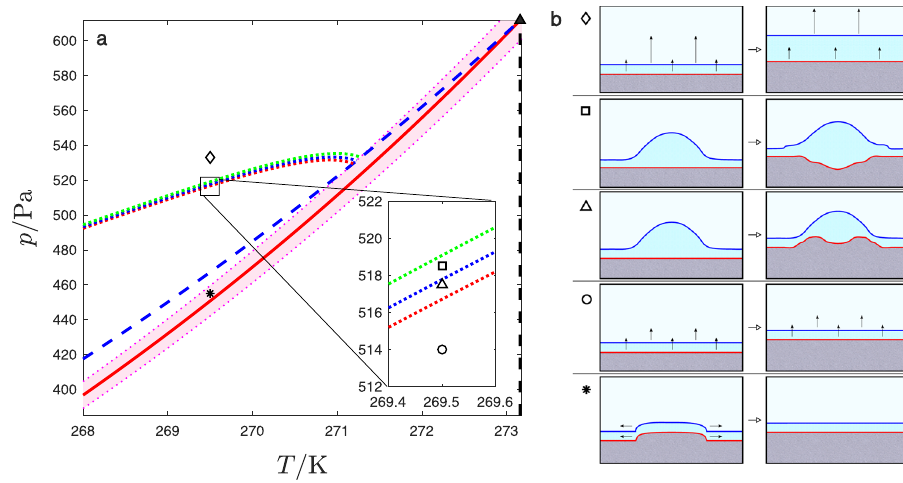
Fig. 3 Kinetic phase diagram for ice crystal growth. Panel a shows the equilibrium phase diagram and kinetic phase lines. The red solid line is the sublimation line, whereas the dashed lines are metastable prolongations of the vaporization (blue) and melting (black) lines. The fi lled triangle ( ▴ ) indicates the triple point where these lines meet. The remaining features describe the outcome of the dynamics. The shaded area designates the region of activated growth. The dotted lines are kinetic phase lines corresponding to kinetic coexistence (red dotted), kinetic α → β transition (blue dotted) and kinetic spinodal (green dotted) lines as explained in the text. Panel b shows sketches with the dynamics observed in different points of the phase diagram, as indicated with the corresponding symbols. The colored lines describe the ice/liquid (red) and the liquid/vapor (blue) surfaces enclosing the premelting fi lm. The black arrows show the direction of preferential growth. At the point marked by an asterisk ( (cid:1) ), in the region of activated dynamics, growth proceeds by horizontal translation of nucleated terraces. At points such as that marked by a circle ( (cid:3) ), above the region of activated dynamics, growth can occur continuously without activation in a steady state of constant fi lm thickness. At points such as that marked by the open triangle ( △ ), above the kinetic coexistence line, droplets can condense and are stabilized transiently with a crater growing inside. At points such as that marked by a square ( □ ), beyond the α → β line, fi lms in the β -thick state can be stabilized transiently and form at the rim of the droplet. At higher pressures, past the kinetic spinodal line (green dotted), such as the point marked with a lozenge ( ♢ ), the crystal growth rate can no longer match the condensation rate, and the fi lm thickness diverges. The detailed dynamics corresponding to symbols in the phase diagram is illustrated in Figs. 4 and